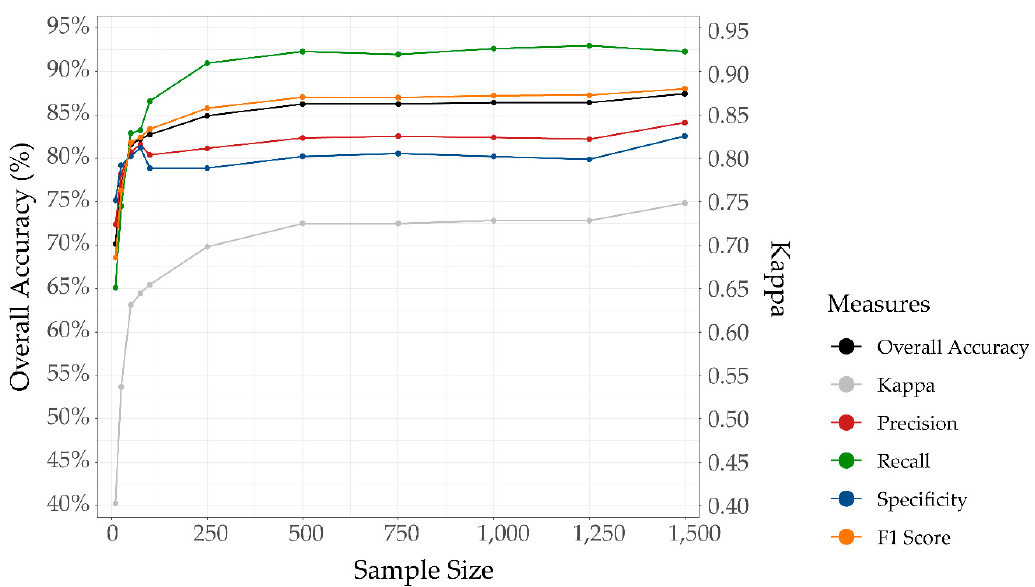
Figure 8. Model comparison at different sample sizes using multiple classification assessment metrics. The sample size represents the number of samples for each class as opposed to the overall sample size.